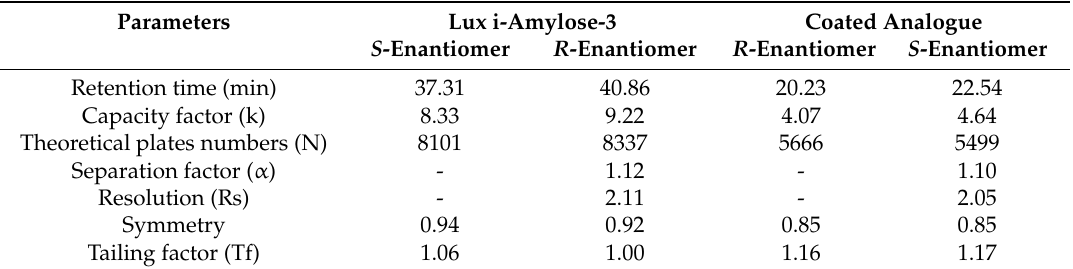
Figure 2. Separation of R - and S -ketoprofen mixture (1 / 2 ratio, w / w ) on amylose tris(3-chloro-5-methylphenylcarbamate)-based chiral columns (250 × 4.6 mm, 5 µ m) with coated ( a ) and immobilized ( b ) chiral selector. Separation temperature was 35 ◦ C, flow rate was 2 mL / min, detection was performed at 254 nm with the mobile phase composition of n-hexane:ethanol:formic acid, 95:5:0.1 ( v / v / v ) for coated ( a ) and n-hexane:ethanol:formic acid, 98:2:0.1 ( v / v / v ) for immobilized ( b ) chiral selector. Table 1. System suitability tests on amylose tris(3-chloro-5-methylphenylcarbamate)-based columns with immobilized and coated chiral